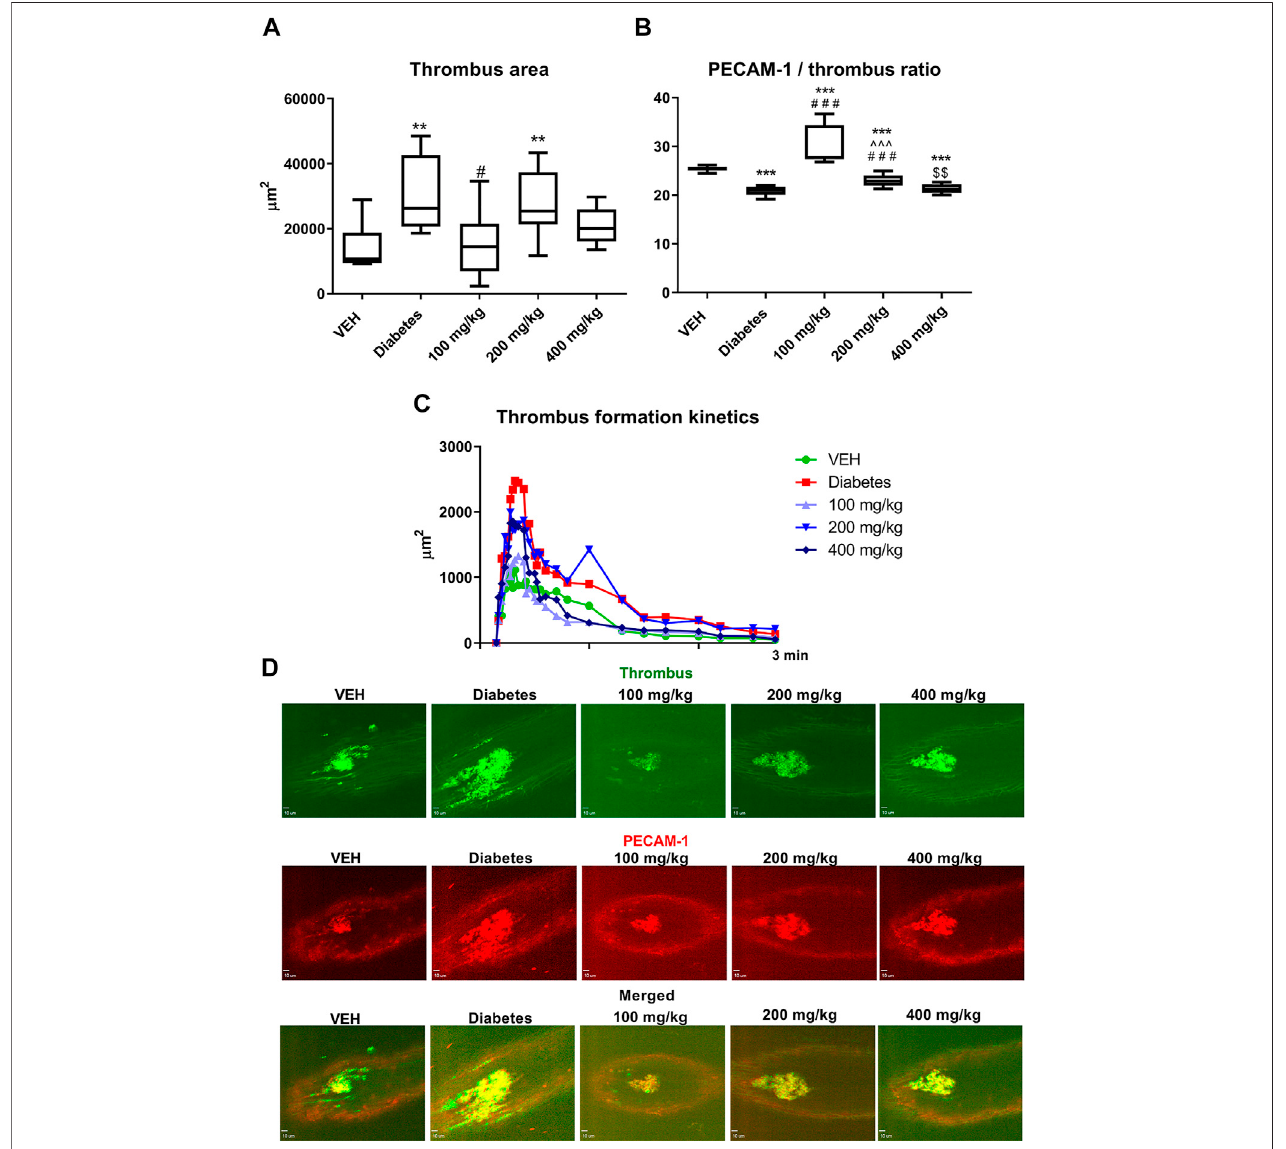
FIGURE5| TheeffectofTEonlaser-inducedthrombosis.TheeffectofTEon:thrombusarea (A) andPECAM-1/thrombusratio (B) .Kineticsofthrombusformation at thesiteoflaserinjury (C) .Representativeconfocalmicroscopyimagesofthrombus(green,toprow),PECAM-1 (red,middle row),andmerged channels (bottom row). Bar (cid:2) 10 µm (D) . ** p < 0.01, *** p < 0.001 vs. VEH; # p < 0.05, ### p < 0.001 vs. Diabetes; ^^^ p < 0.001 vs. 100 mg/kg; $$ p < 0.01 vs. 200 mg/kg; n (cid:2) 7 – 10. Data are shown as median (interquartile